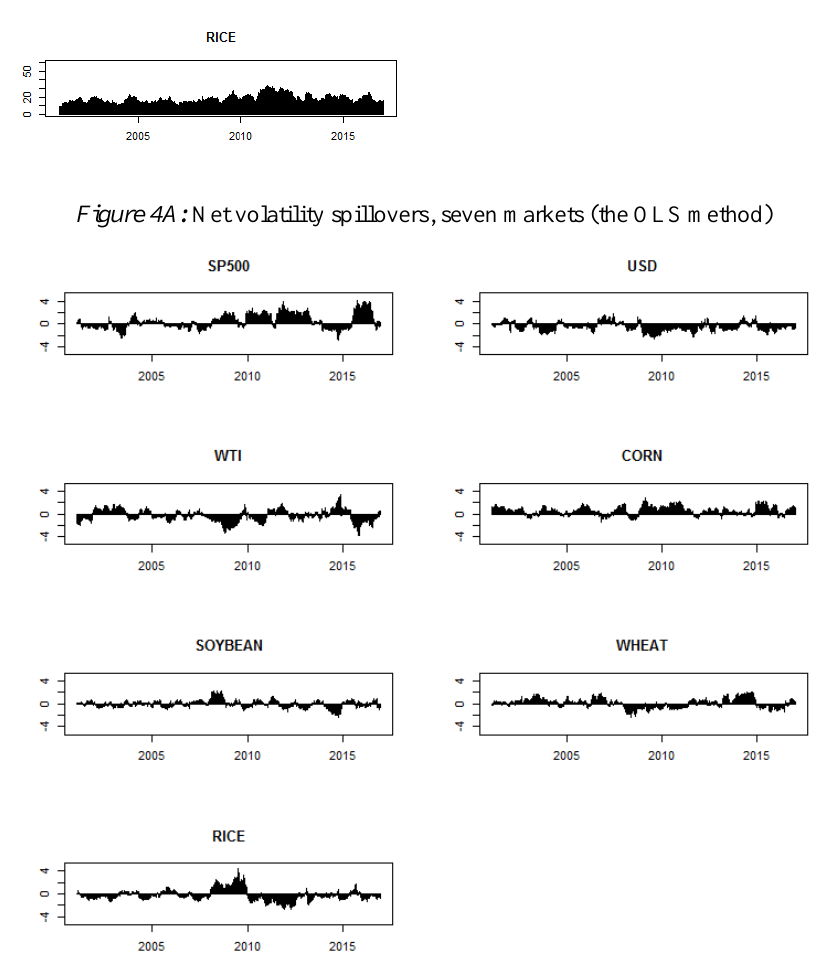
Figure 4A: Net volatility spillovers, seven markets (the OLS